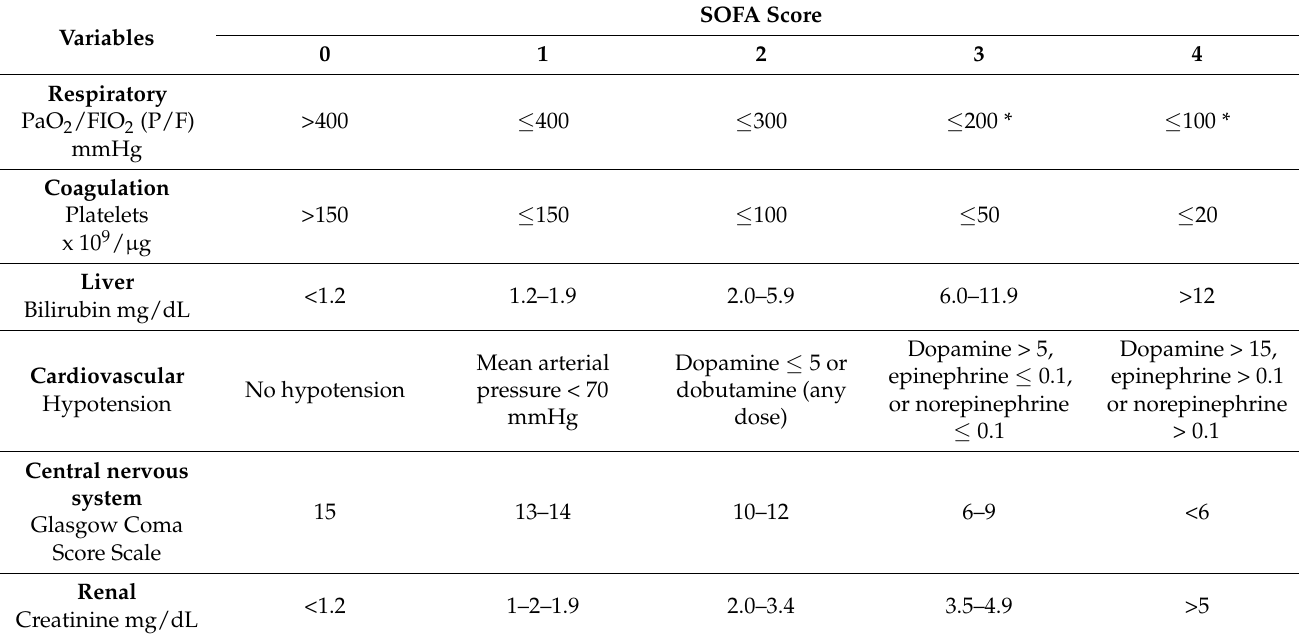
Table 1. The Sequential Organ Failure Assessment (SOFA)